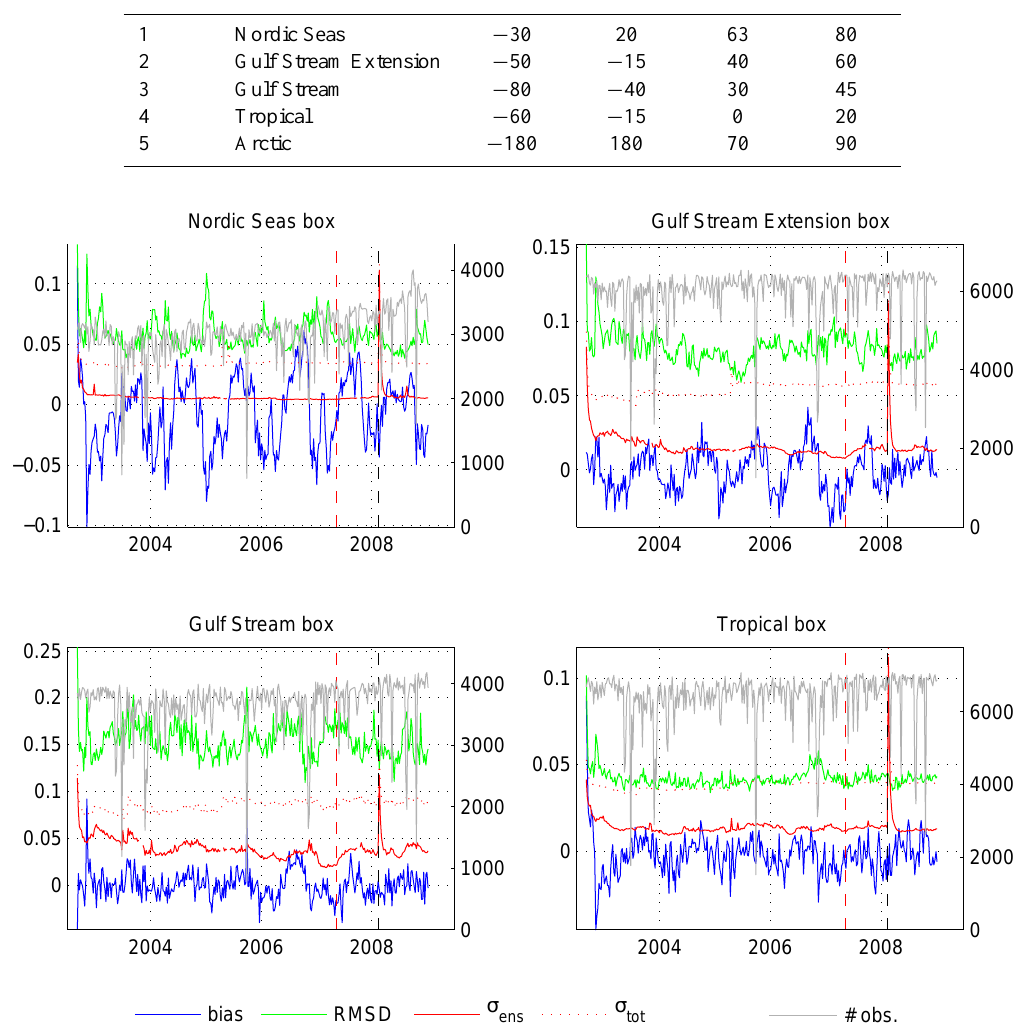
Fig. 5. Time series of regionally-averaged innovation statistics for satellite-derived SLA observations, including the bias (mean observed minus mean background; negative innovation bias corresponds to a warmer model), the RMSD between the observations and the model background field of the innovation, the ensemble spread σ ens , and the estimated standard deviation of the innovation σ tot (the quadrature sum of σ ens and the assumed standard deviation of the observation errors). The boundaries to the regions are denoted in Fig. 1. The number of observations assimilated is also shown (grey line) with its corresponding axis on the right-hand-side of each panel. The Arctic region is not represented because there are no reliable remote SSH observations